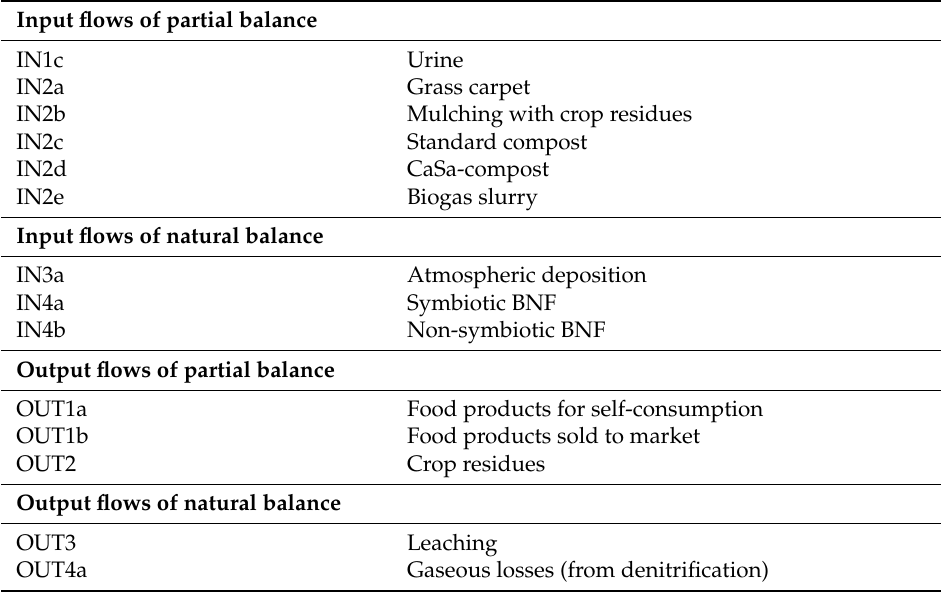
Table 3. Selected flows considered in soil nutrient